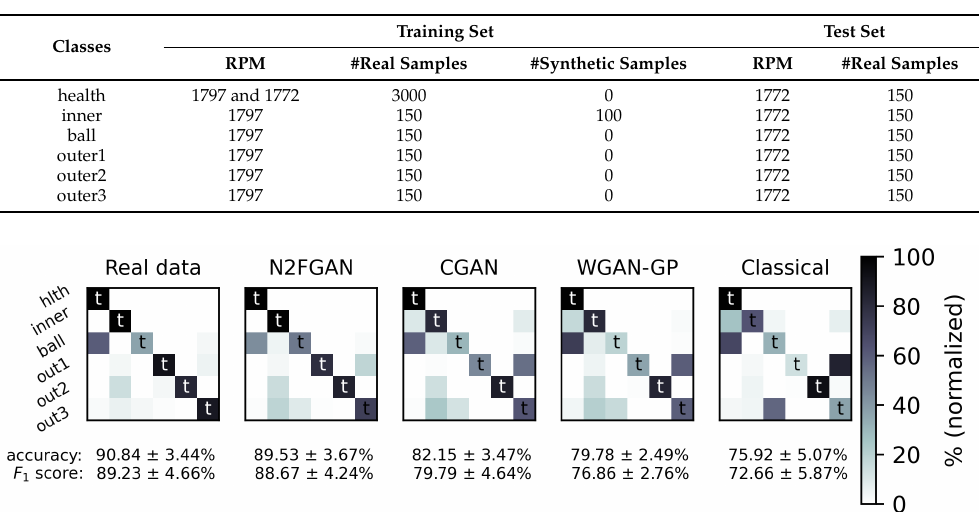
Table 5. Training and test set configuration for comparing N2FGAN, CGAN, WGAN, and classical augmentation.